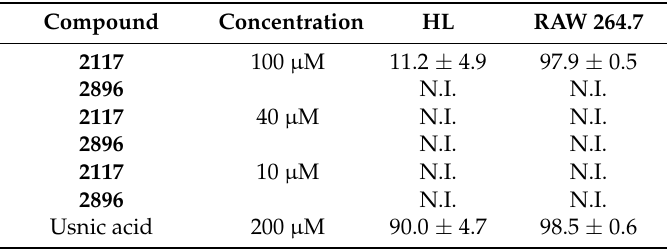
Table 4. Inhibition-% of cell viability after 24 h exposure to the lead compounds. Results are reported as mean ± SD, n = 3. N.I. = no inhibition. Cytotoxicity was tested in human lung (HL) epithelial cells and mouse monocyte macrophage (RAW 264.7)